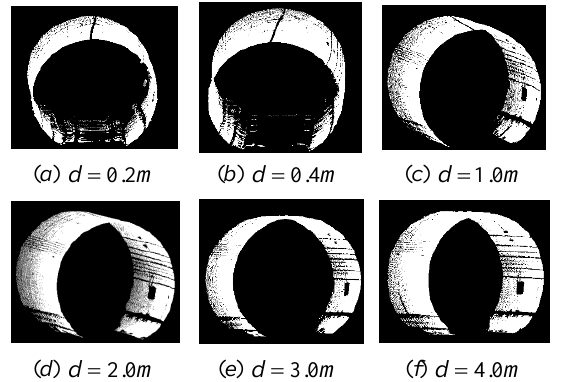
Fig.6 Filtering effect diagram with different width